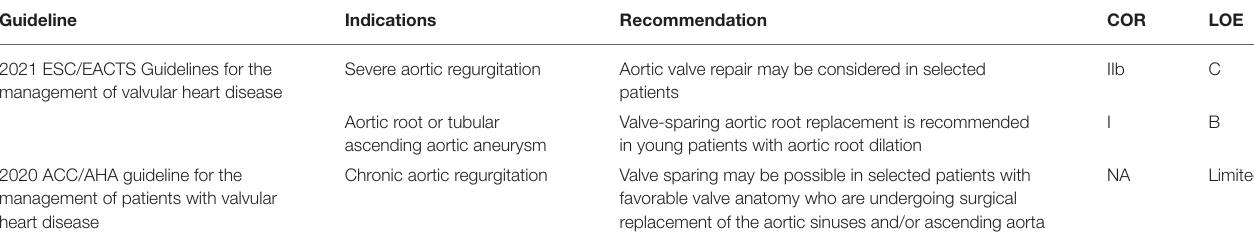
TABLE 1 | Criteria to perform an aortic valve (AV) repair according to updated guidelines.